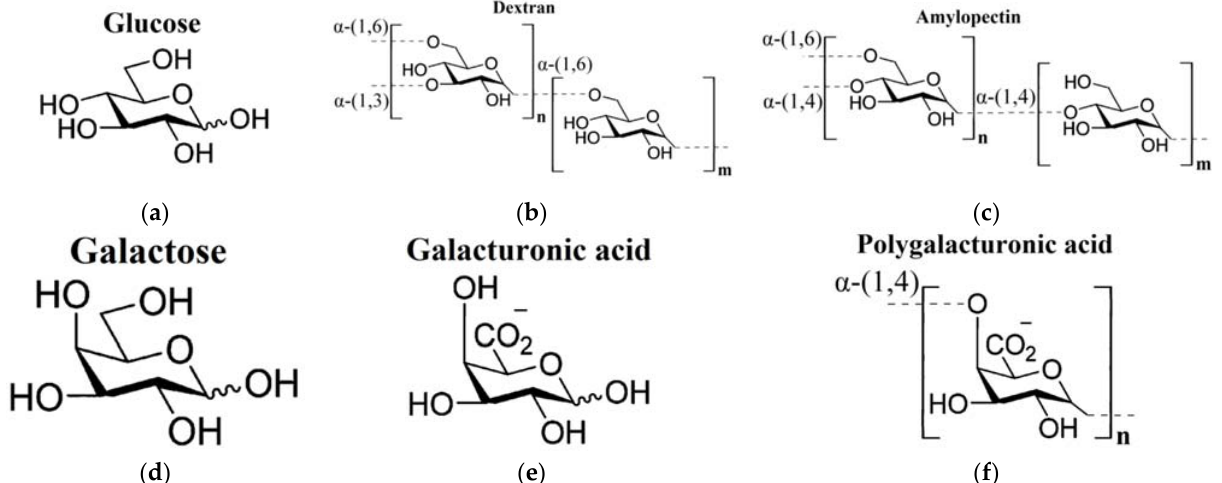
Figure 1. Chemical structures of the studied carbohydrates [66]: ( a ) glucose; ( b ) dextran and ( c ) amylopectin (polysaccharides of glucose); ( d ) galactose (a stereoisomer of glucose); ( e ) galacturonic acid; ( f ) polygalacturonic acid.